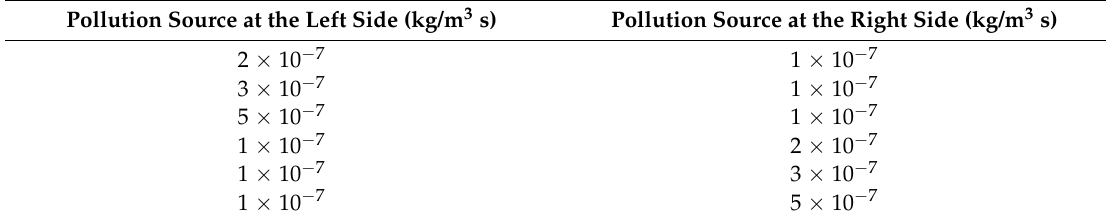
Table 3. Simulation setting value of pollution source on both sides.